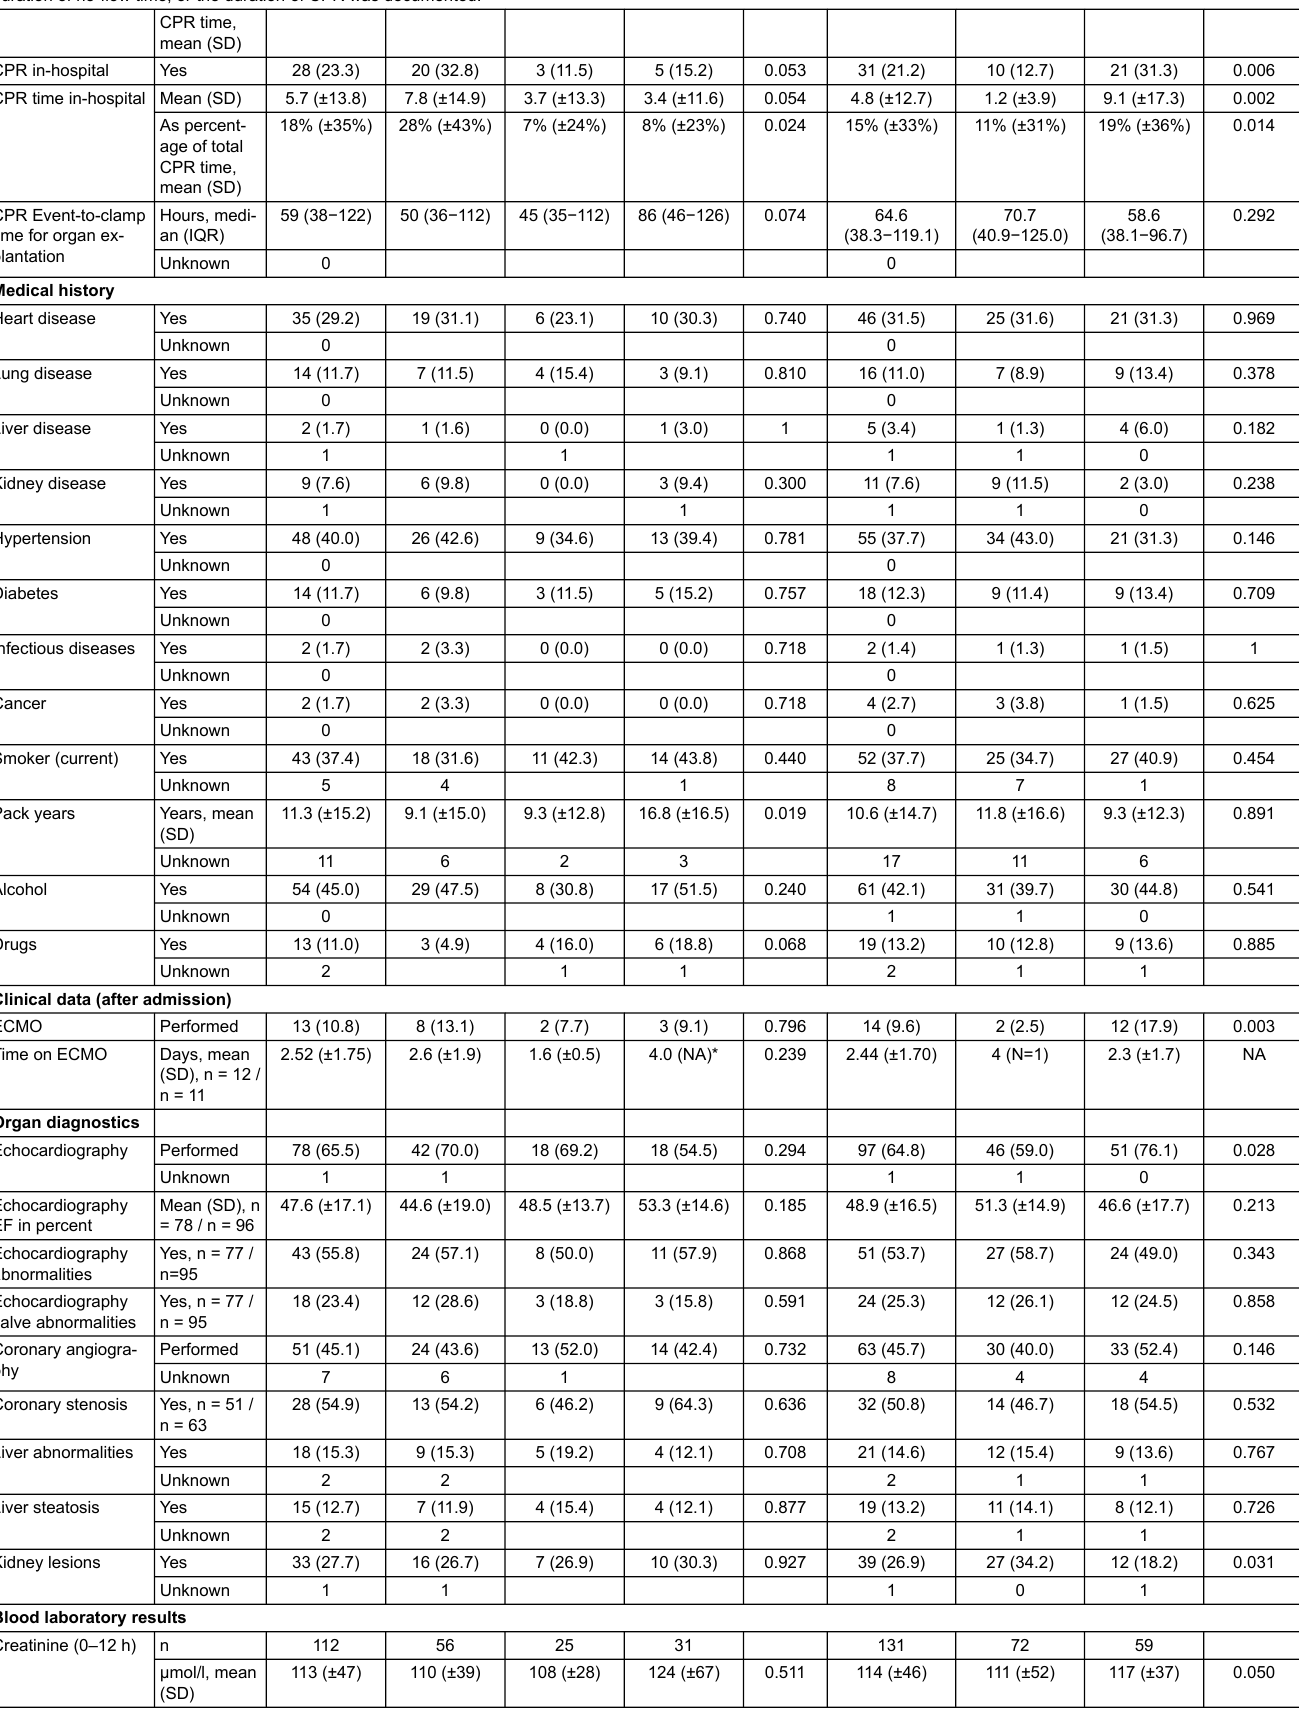
Table S1: Complete table for the analysis of the effect of CPR duration and no-flow time; included are only utilised donors (at least one organ transplanted) for whom either the duration of no-flow time, or the duration of CPR was